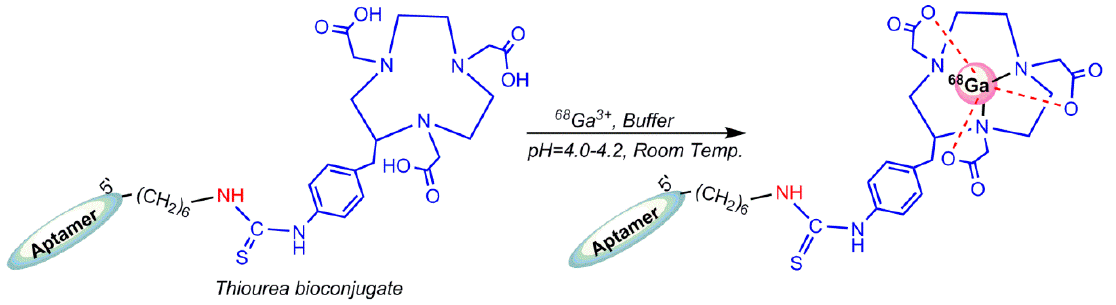
Figure 20. Thiol–maleimide bioconjugation reaction of maleimidoethylmonoamide(MMA)–NOTA to a hexylthiol-functionalized oligonucleotide.